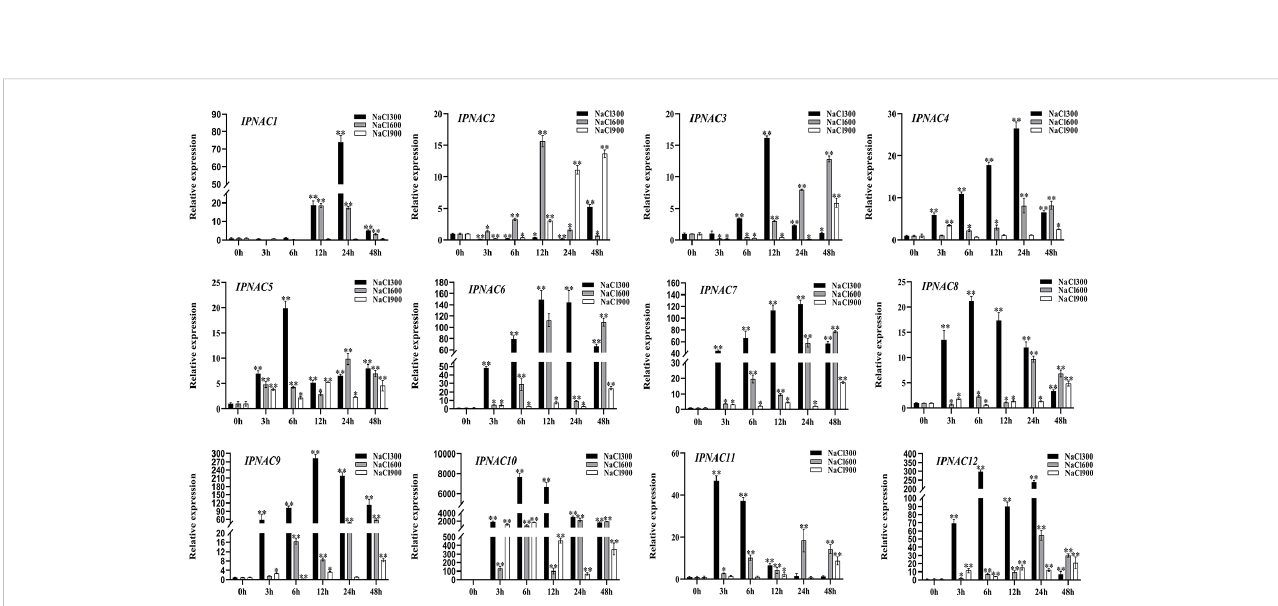
FIGURE 4 The expression level of IpNAC genes under different salt treatments. The roots were soaked in 300, 600, and 900 mM NaCl solutions and collected at different time points (0, 3, 6, 12, 24, and 48 h). The expression of IpNAC genes under salt treatment was detected by quantitative real-time PCR. Non- stressed plants (0 h) were used as a control, and each experiment was conducted with three biological replicates and three technical replicates. The mean values and SD were obtained from the experiment. The p-values were evaluated using Student ’ s t -test. Asterisks indicate the level of signi fi cance, ** p < 0.01 and * 0.01 < p < 0.05 . Transcript levels at 0 h were set as